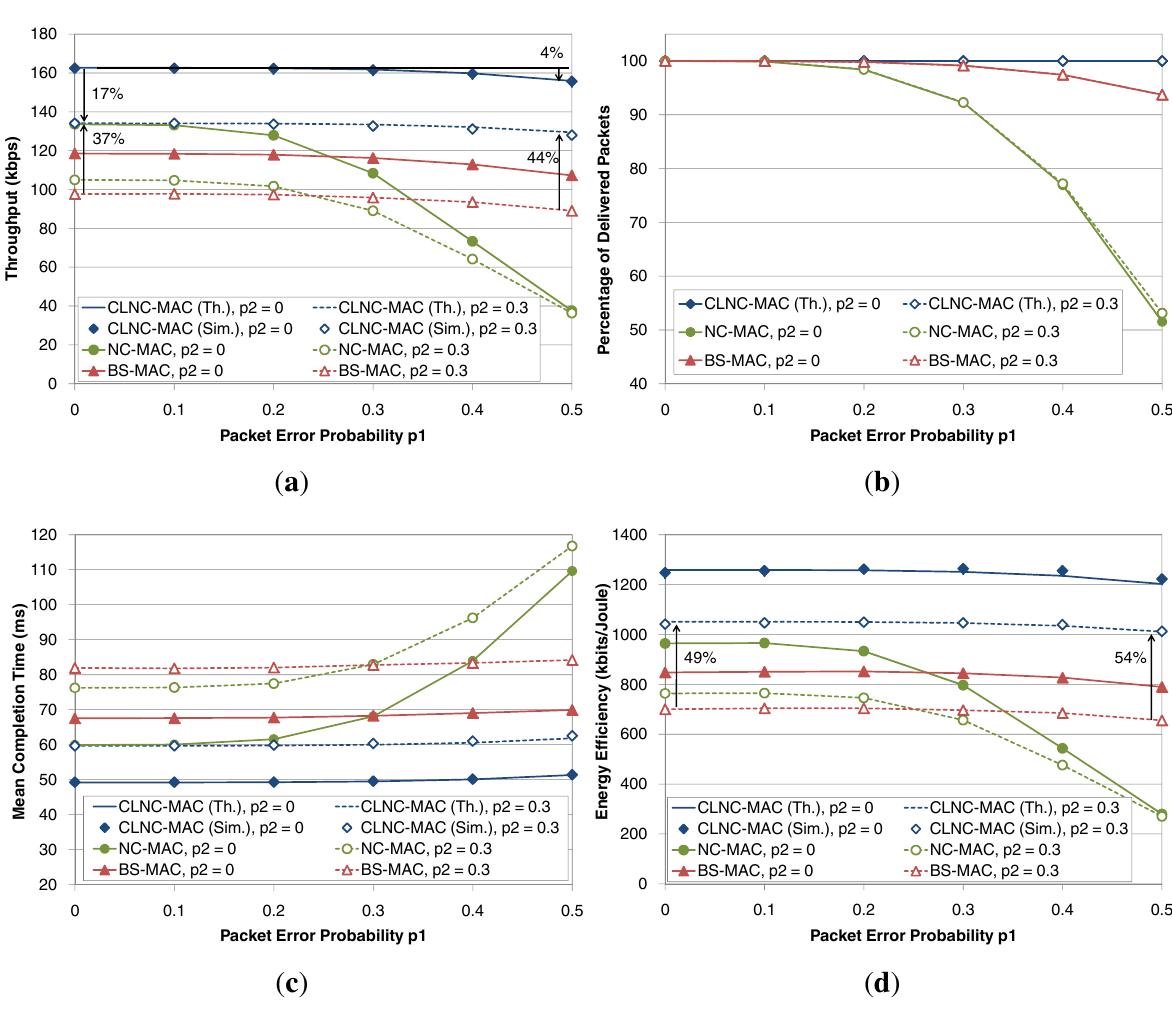
Figure 10. Performance evaluation as a function of the packet error probability between source and relays p , for R = 4 relays. ( a ) Throughput; ( b ) percentage of successfully 1 delivered packets; ( c ) mean data delay; ( d ) energy